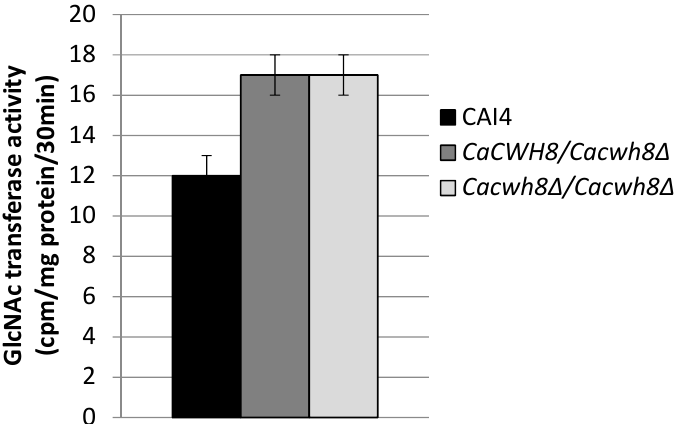
Figure7. ActivityofGlcNActransferaseinmembranefractionsfromthewildtype C.albicans strainCAI4 and the CaCWH8 mutants. Data are mean ± standard deviation from five independent experiments.